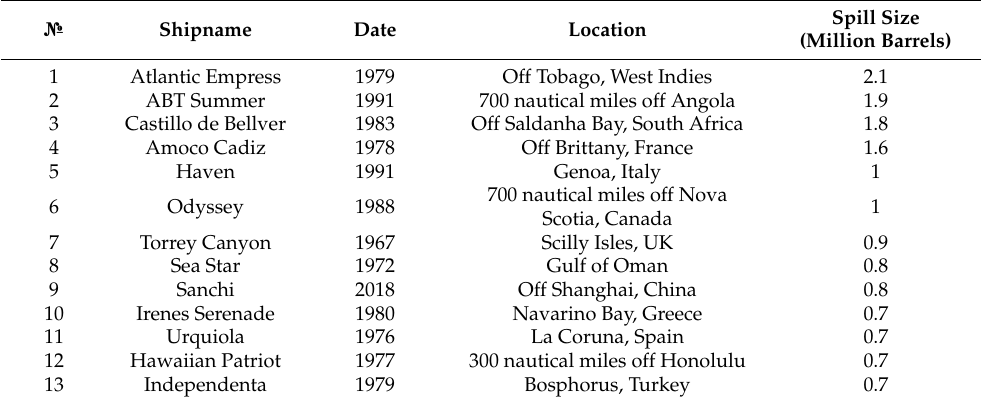
Table 1. Major ship spills